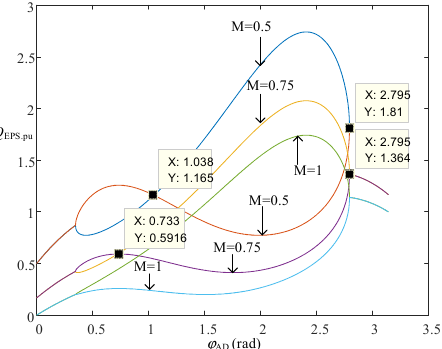
Figure 12. P EPS.pu = 0.67 at different gain M , the relation curve between Q EPS.pu and the bridge phase-shift angle ϕ AD .